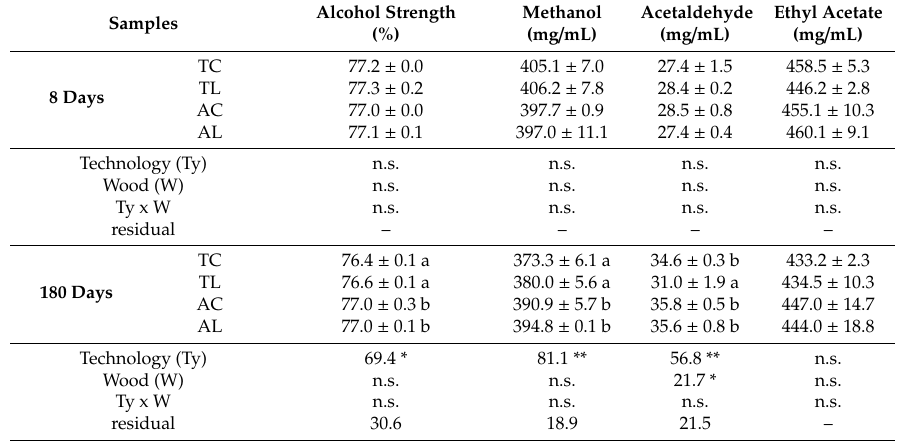
Table 1. Di ff erences in alcohol strength, methanol, acetaldehyde and ethyl acetate of the wine spirits aged with Limousin oak and chestnut wood in two di ff erent